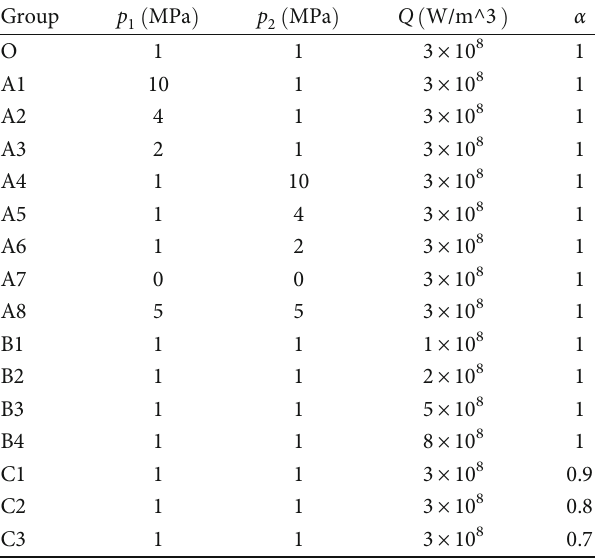
Figure 2: Meshing. Table 2: Parameters of the simulation groups.